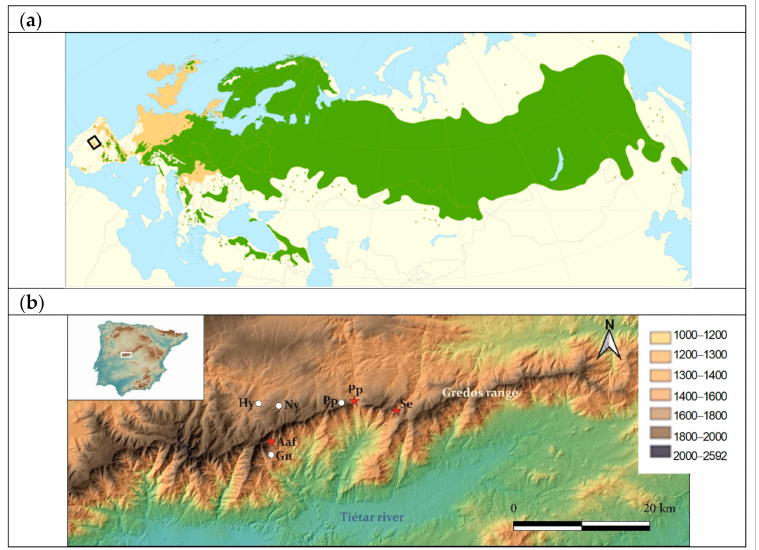
Figure 1. ( a ) Distribution area of Scots pine ( Pinus sylvestris ) across Eurasia showing native (green patches) and introduced or naturalized stands (brown patches; source [21]). Dots indicate isolated Scots pine populations. ( b ) Location of four Scots pine forests (white circles) investigated in the Sierra de Gredos mountains, central Spain (Gu: Guisando; Pp: Puerto del Pico; Hy: Hoyos del Espino; Nv: Navarredonda) and pollen/charcoal records (red stars: Pp, Puerto del Pico; Se, Serranillos; Aaf, Arroyo de Aguas Fr í as). Elevation is given in m